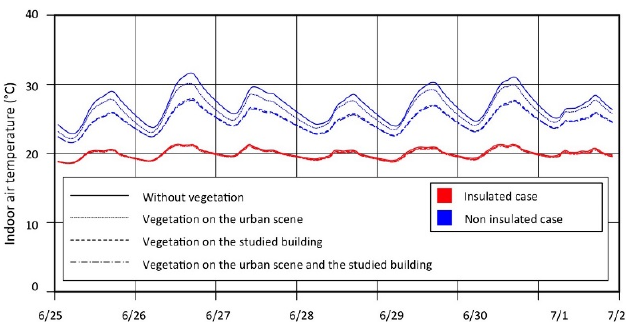
Figure 7. Indoor air temperatures (average of all five floors) for the insulated and non ‐ insulated cases.